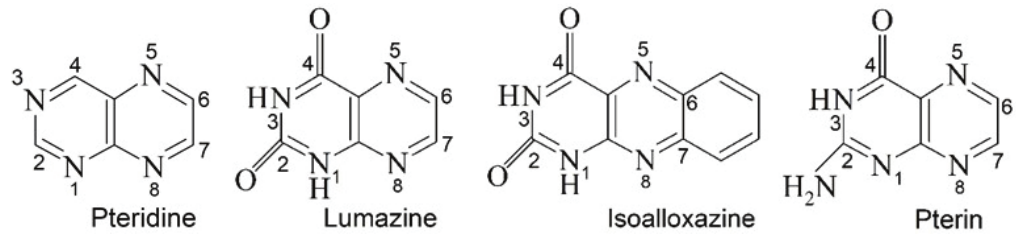
Figure 1: Different natural pterin moieties.